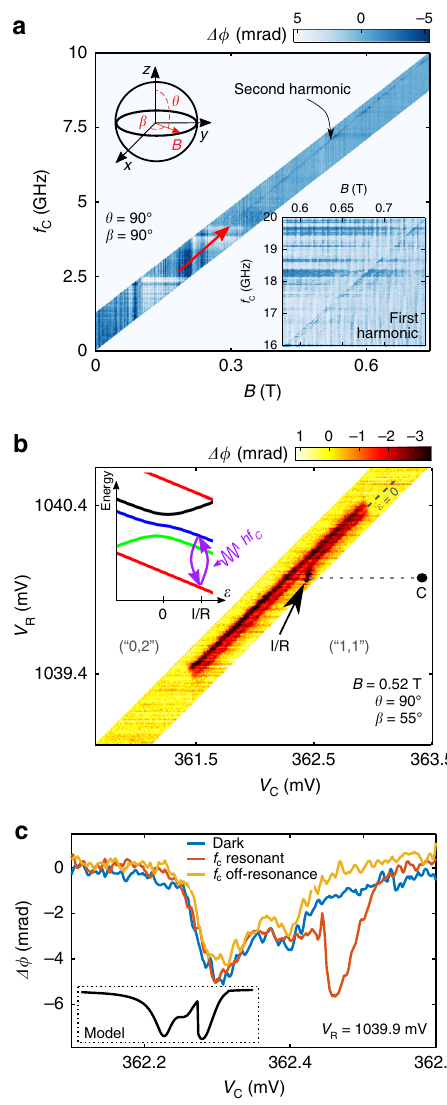
Fig. 3 Experimental detection of electric-dipole spin resonance (EDSR). a Phase response as a function of B and microwave frequency f C . B is oriented along the y direction with respect to the frame of Fig. 1a. The linear phase ridge denoted by a red arrow is a characteristic signature of EDSR. It corresponds to a second-harmonic signal, while the much weaker fi rst harmonic is shown in the lower inset. b Stability diagram at B = 0.52 T (orientation β = 55° and θ = 90° according to the diagram in upper inset of a) with f C = 7.42 GHz and microwave power P C ≈ − 80 dBm. EDSR between T − (1, 1) and T 0 (1, 1) (purple arrows in inset) is driven at point I . In the stability diagram, the change of population induced by EDSR is visible as a localized phase signal at point I/R. c Phase shift at V R = 1039.9 mV as a function of V C without microwave irradiation (dark), and under on- resonance and off-resonance excitation at f C = 7.42 and 7.60 GHz, respectively. EDSR-stimulated transitions appear as a pronounced peak whose position and line shape are compatible with our model The DQD is initially tuned to the position of the red star in Fig. 2c, where the DQD is in a “ shallow ” (1,1) con fi guration, i.e. close to the boundary with the (0,2) charge state (more details in Supplementary Note 4 and Supplementary Fig. 4). Figure 3a shows the dispersive measurement of an EDSR line. The microwave gate modulation of frequency f C is applied continuously and B is oriented along the nanowire axis.